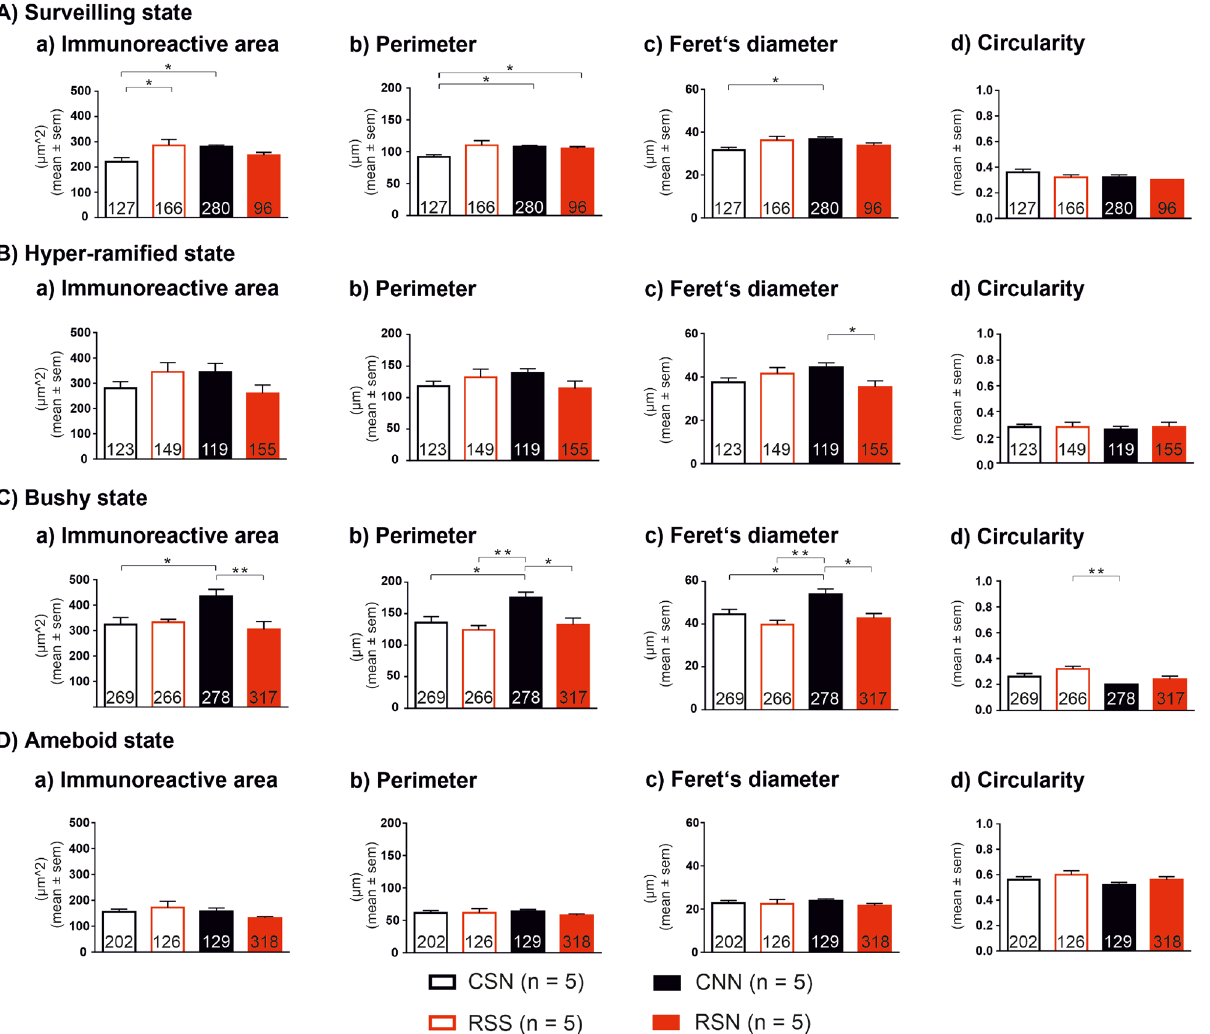
RSS, CNN, RSN). Total numbers of microglia cells evaluated are given inside respective bars; the ranges of numbers of cells per animal are: ( A ) Surveilling state: CSN: 16–51, RSS: 13–53, CNN: 34–84, RSN: 1–42; ( B